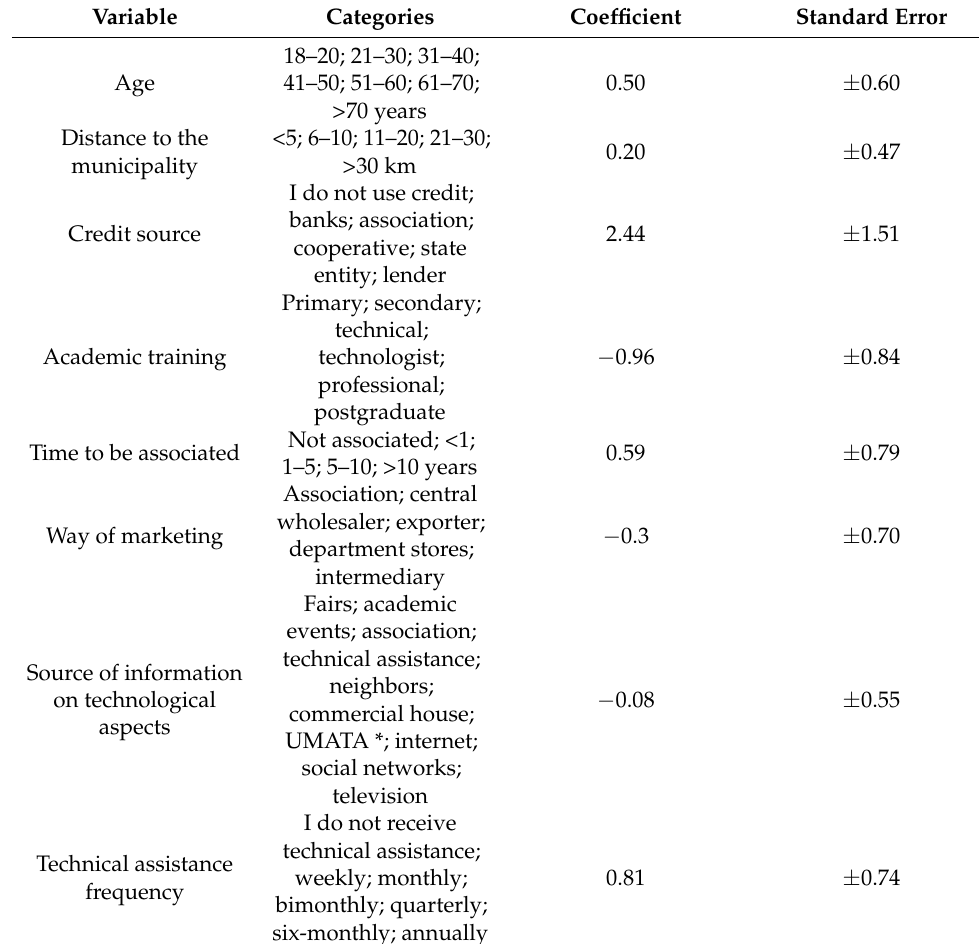
Table 2. Variables and categories used for the multinomial logistic regression model and coefficients assigned by the model. Variable Categories